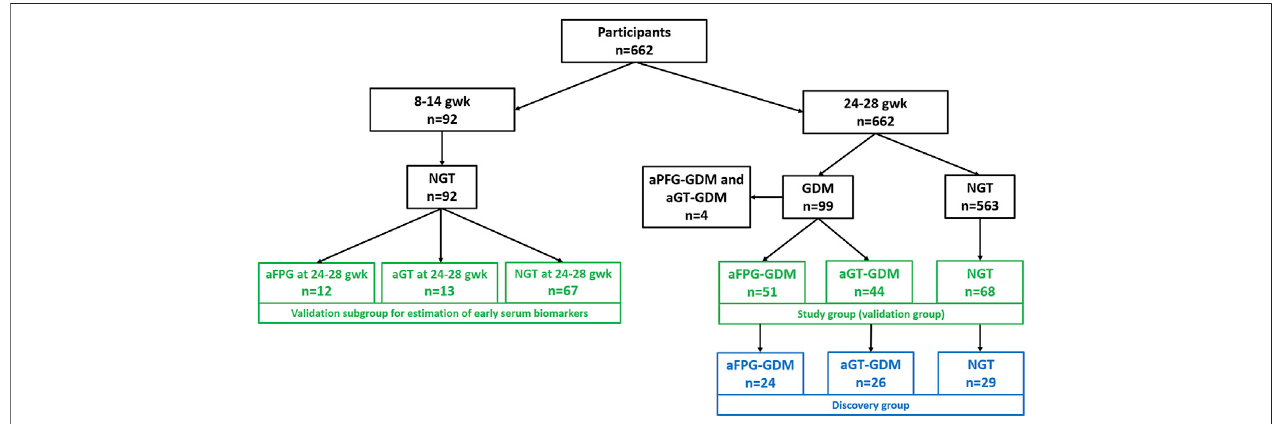
FIGURE 1 | Flow chart presenting participants ’ selection. Samples selected for the discovery phase are presented in blue rectangles, while those for the validation stage, in green